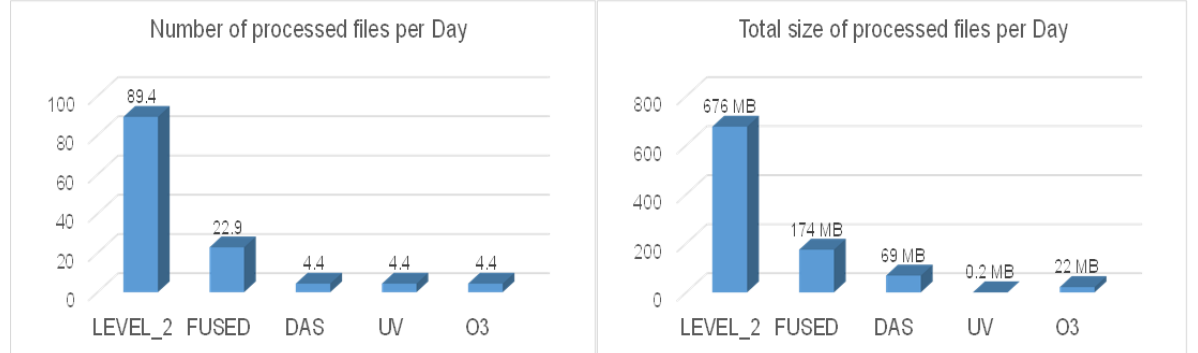
Figure 13. The number of files processed per day ( left ) and the size processed per day ( right